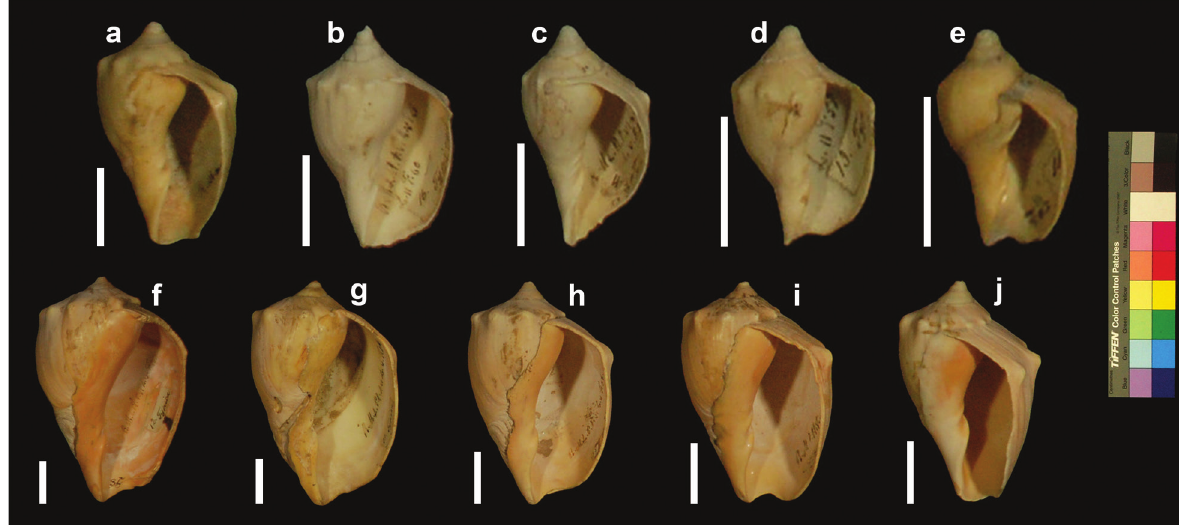
Figure 28. Voluta colocynthis typica , specimens figured by Lahille (1895). See references on Table 10. Scale bars: 3 cm.